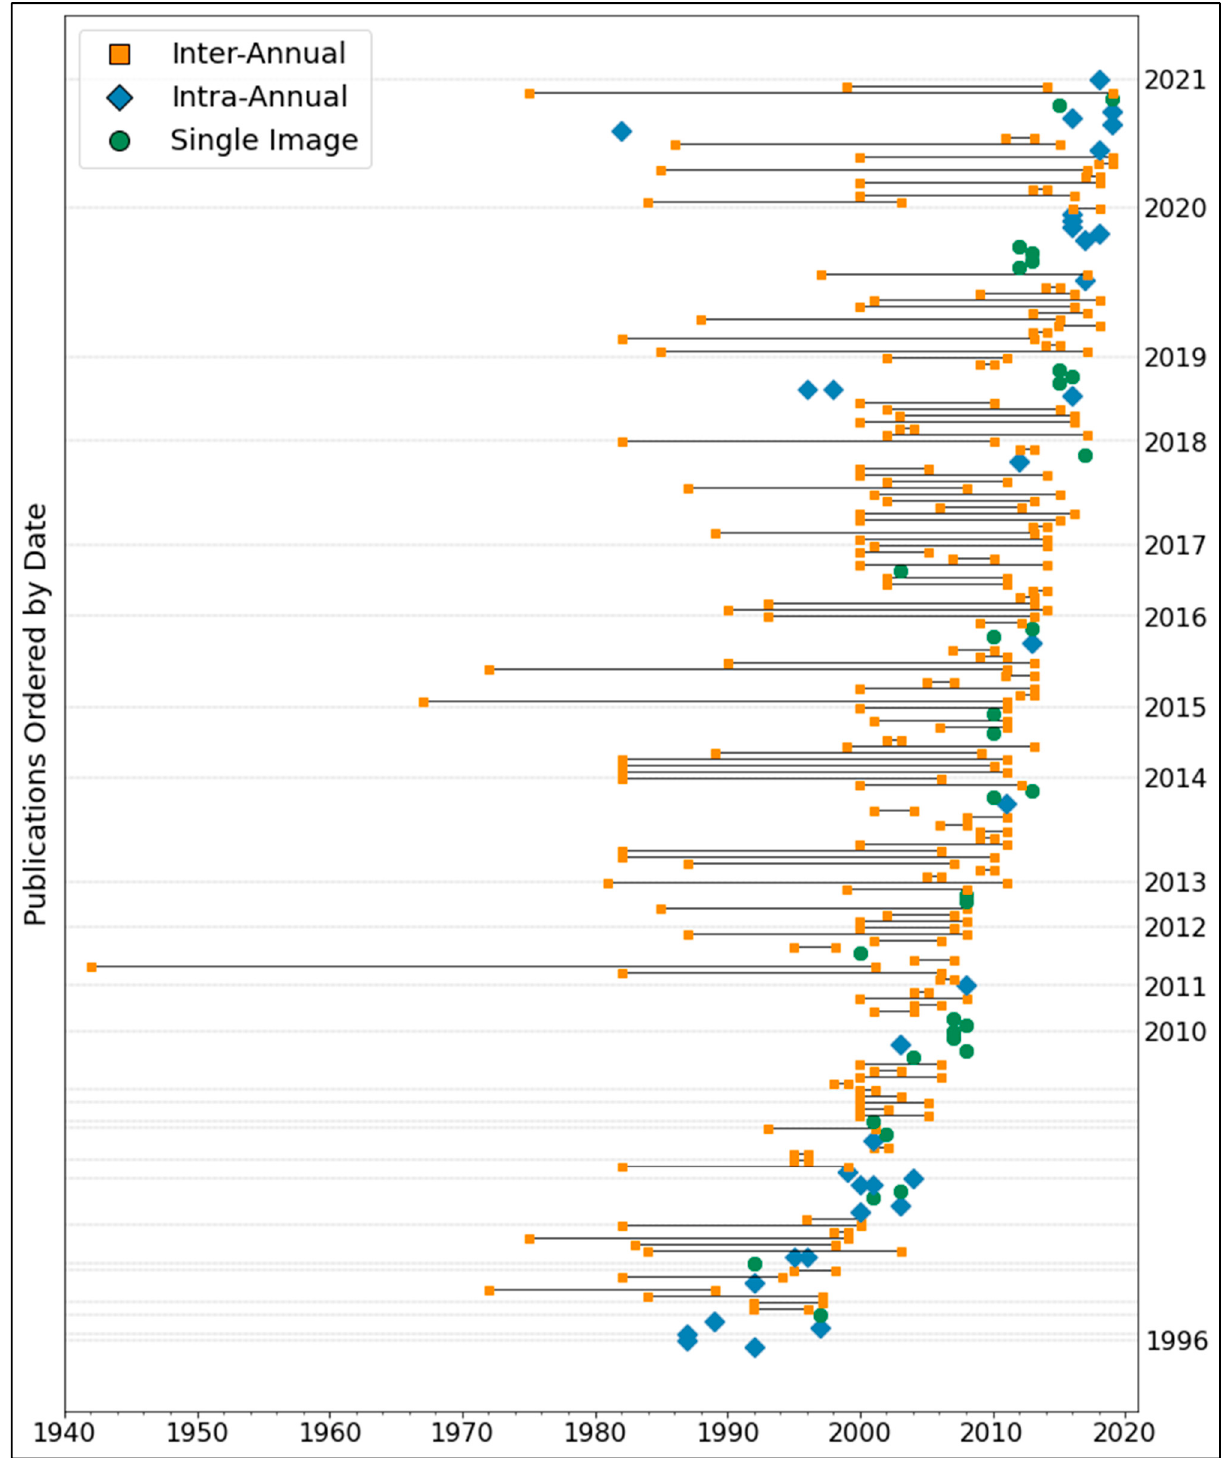
Figure 11. The length of analysis in years for the reviewed publications. Studies’ length of investigation is shown on x -axis with the publication year shown for every publication on y -axis. Inter-annual studies which represent investigating periods covering multiple years are illustrated by a line with orange square at the ends, while multiple images spanning over a single year (intra-annual) are represented by blue diamond shape point, and single images which represent a mono-temporal single date are indicated by single round green point symbol. The graph was generated with courtesy of a Python code generated by Sophie Reinnerman of German Aerospace Center (DLR).